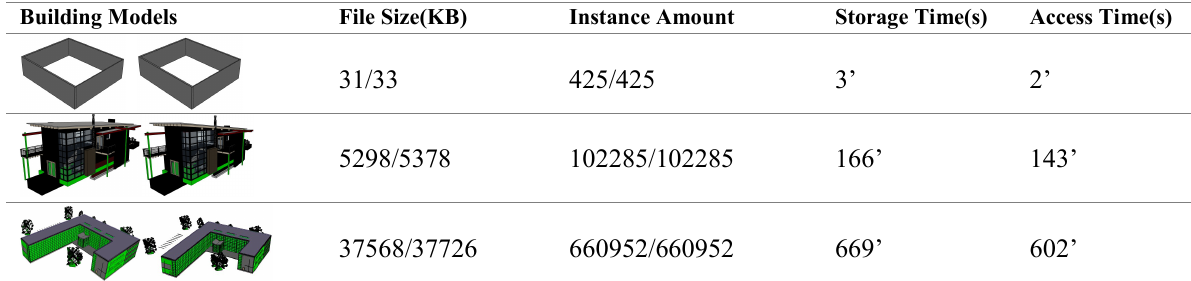
Table 3. Comparison of statistics of different models